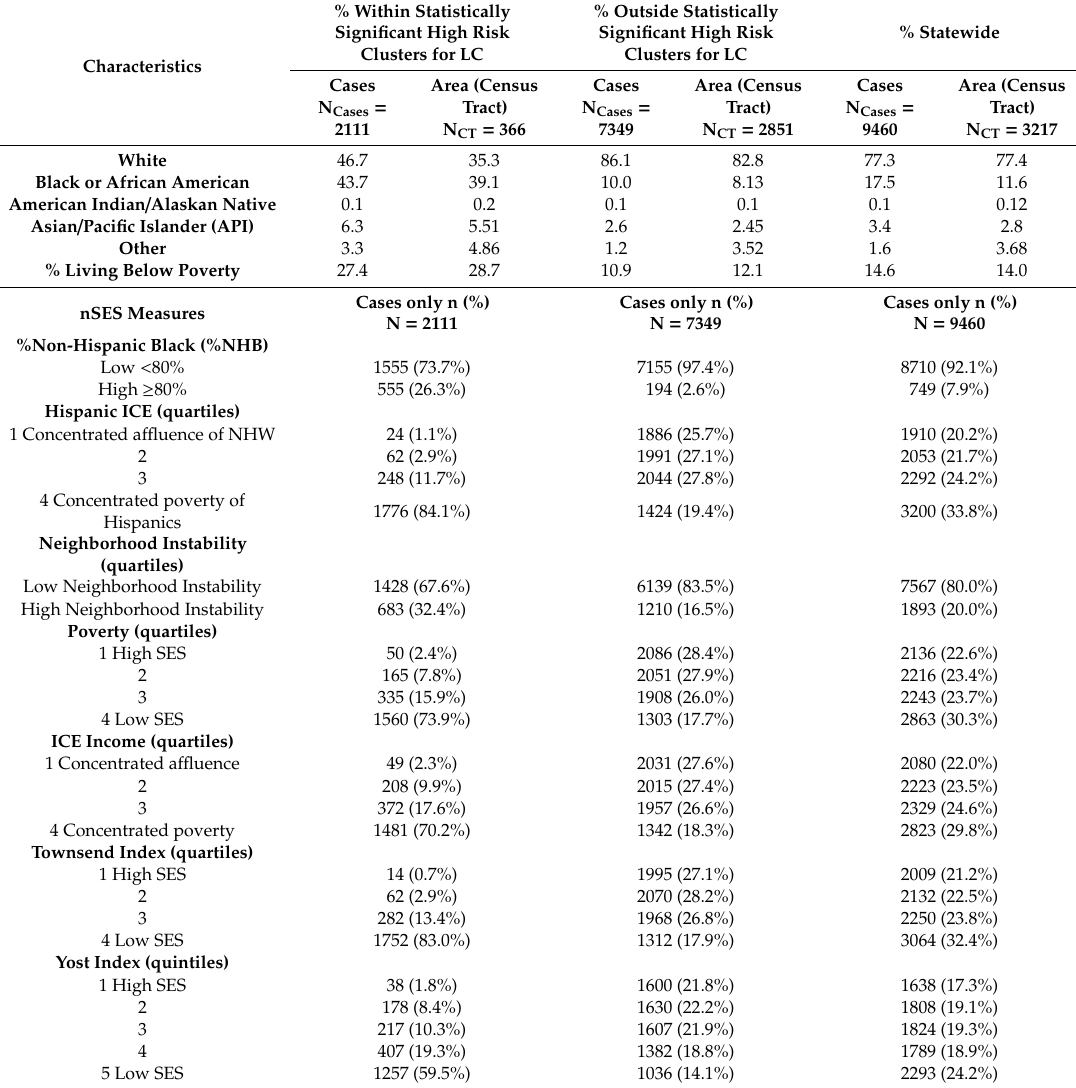
Table 2. Individual and Neighborhood Level Characteristics of Liver Cancer